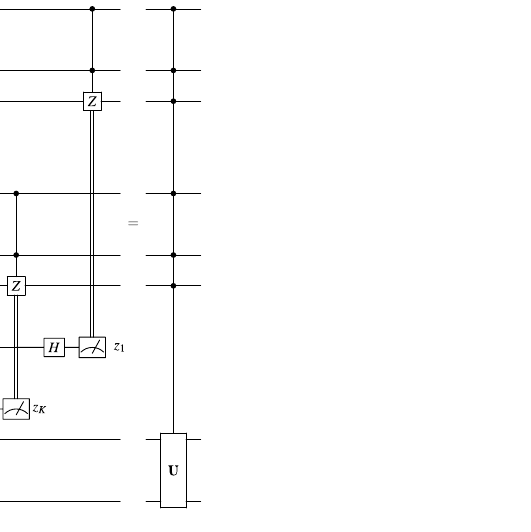
Figure 2. Improved multipartite distribution of N -control unitaries 12